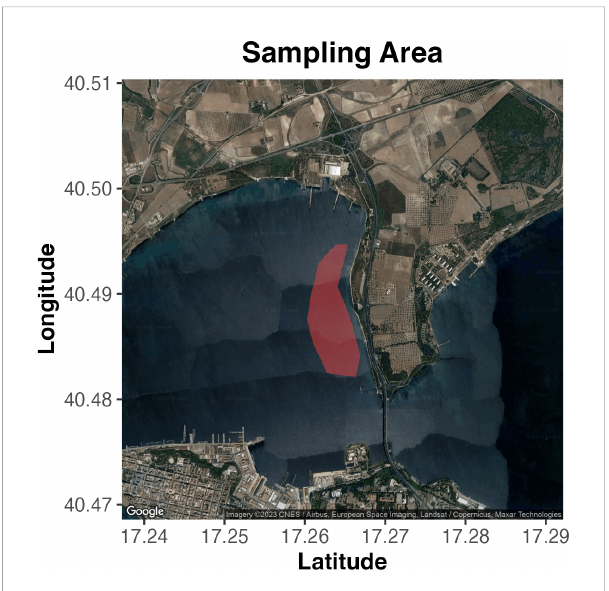
FIGURE 1 Map of the sampling area in the Mar Piccolo of